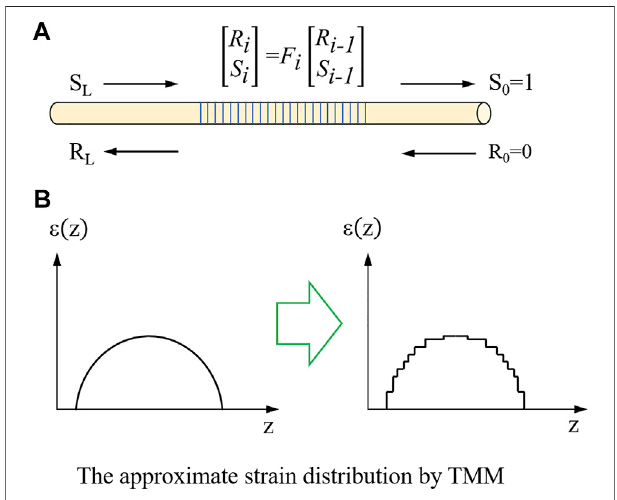
FIGURE 2 | (A) Propagation of a waveguide in an optical fi ber. (B) Discrete strain distribution by the TMM.